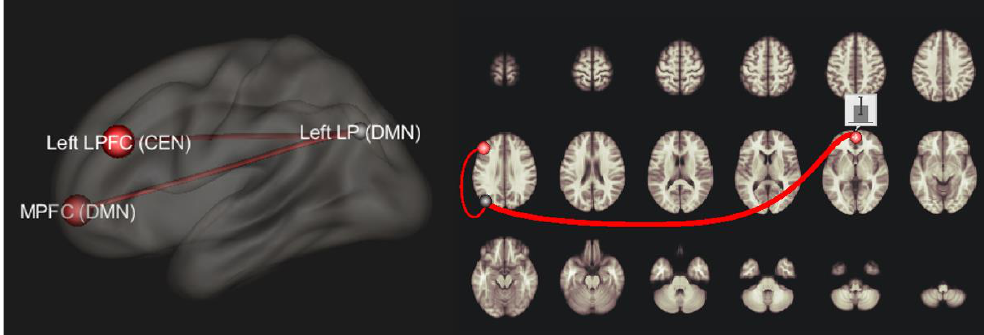
Table 3. Resting-state fMRI network-to-network findings between depressed patients and HC group and between depressed FTD and PD patients and HC (higher connectivity between seeds have a positive value of T-score; LP: lateral parietal lobule; DMN: default-mode network; LPFC: lateral prefrontal cortex; CEN: central executive network; MPFC: medial prefrontal cortex; p-FDR: p -value corrected for false discovery rate).